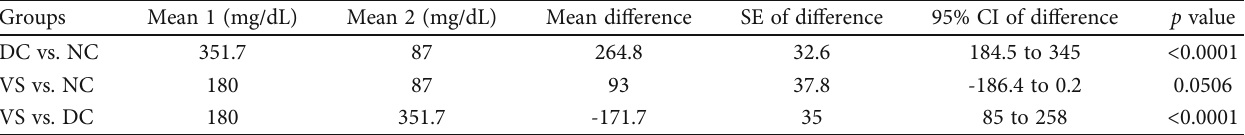
Table 1: Statistical analysis ∗ of FBG values in the di ff erent experimental groups, one week after STZ injection. Groups